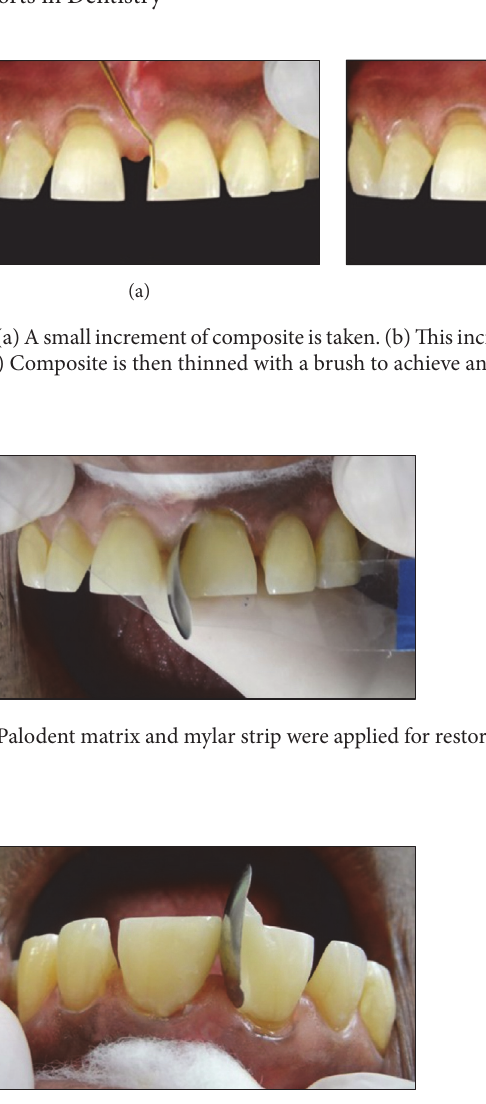
Figure 6: Restoration of 11-matrix should be inserted slightly into the sulcus for correct emergence profile of the composite.